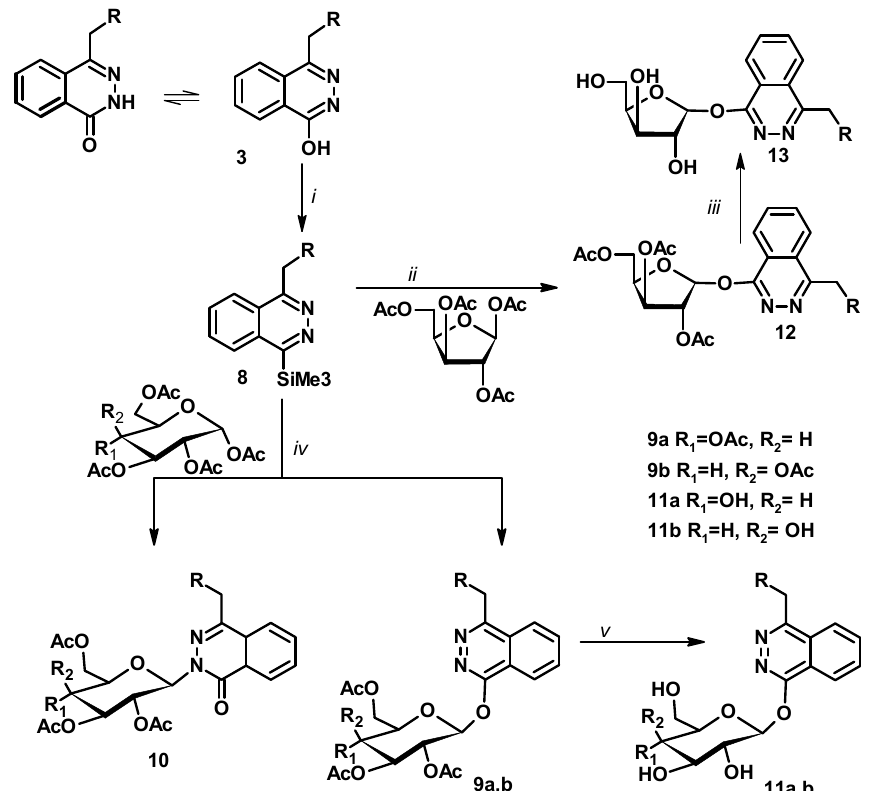
Scheme 2. Synthesis of 4 ‐ (pyren ‐ 1 ‐ ylmethyl) ‐ 1 ‐ ( D ‐ glycosyloxy) phthalazine nucleosides 11a , b